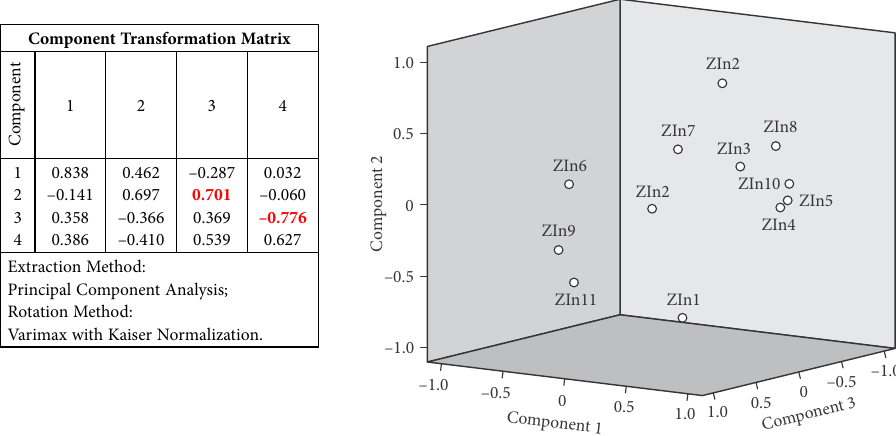
Figure 4. SPSS  , Component Transformation